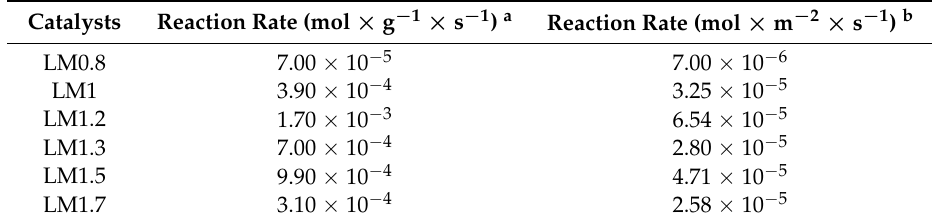
Table 5. Reaction rate of LM catalysts in terms of gram of catalyst and specific surface area for toluene total